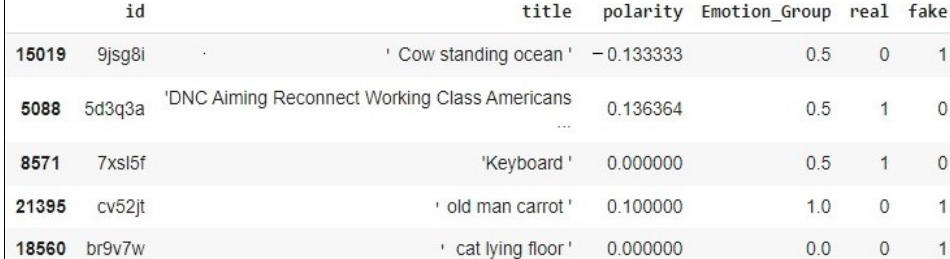
Figure 8. The screenshot of the final dataset used in the proposed model.